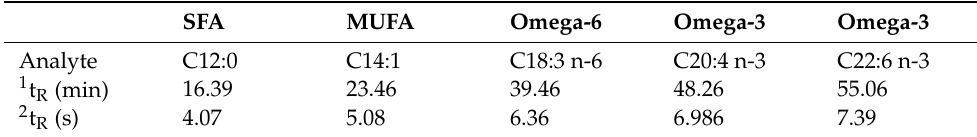
Table 2. Selected representative of each class for response